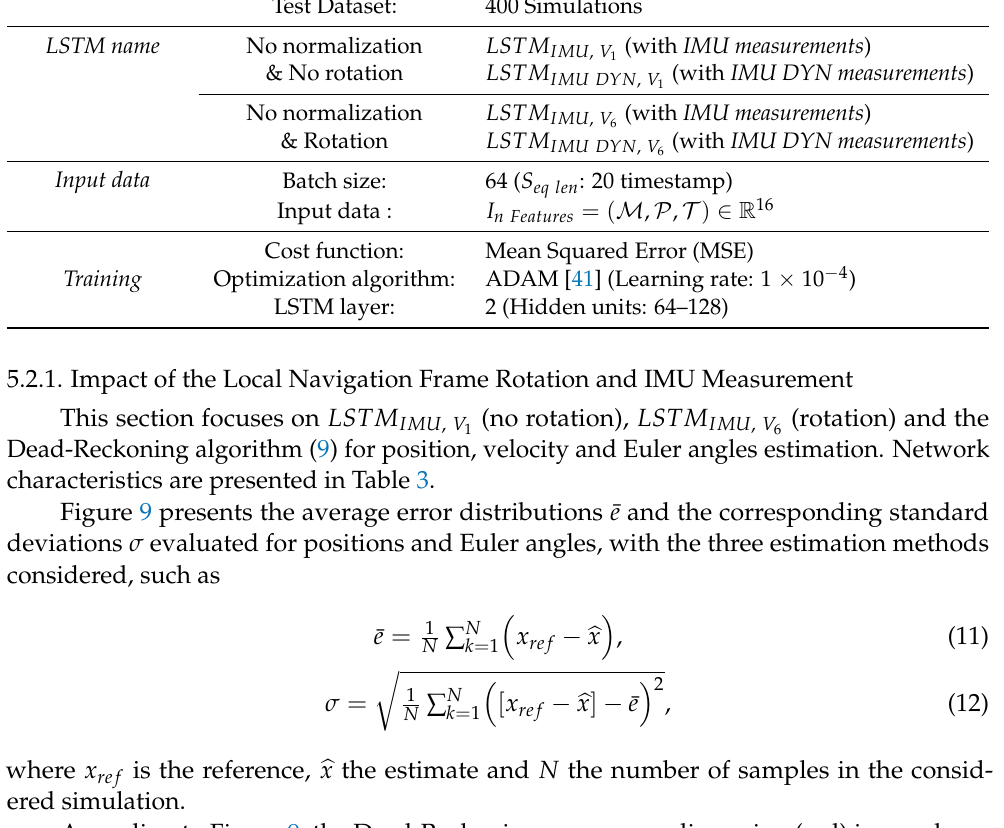
, LSTM IMU DYN , V 1